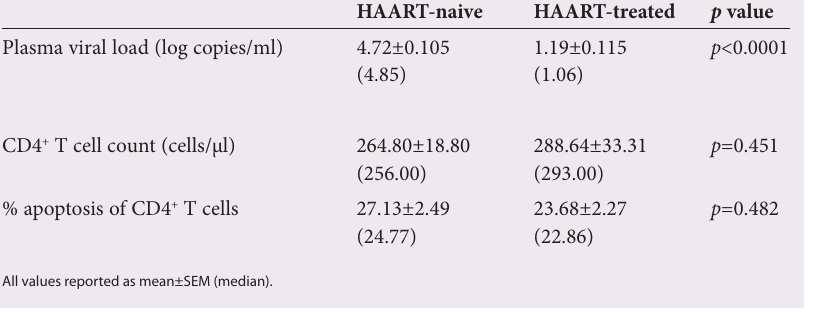
Table 3. Markers of HIV progression in HAART-naive and HAART-treat- ed groups in HIV-positive